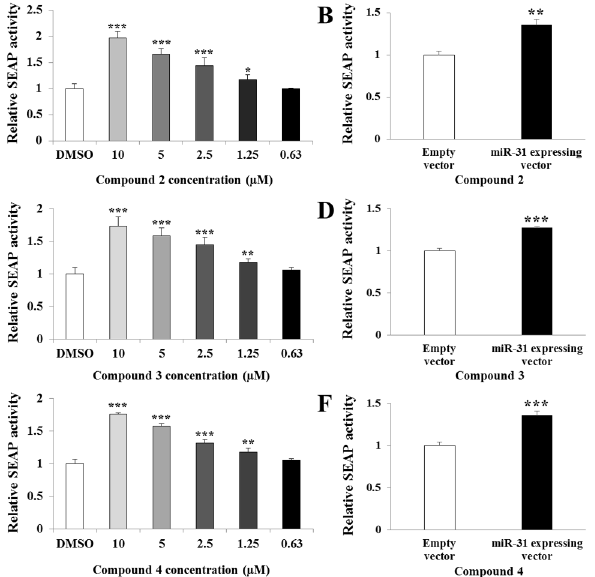
Fig 2. Screening of compounds with miR-31-modulating activity using the SEAP reporter assay. HEK- 293Tcells were co-transfected with the miR-31expressionconstruct (A, C, E) or empty miRNAexpression construct (B, D, F) and the SEAP reporterconstructcontainingmiR-31bindingsites in the 3 0 UTR of the SEAP reportergeneand subsequently treated with the compoundsfor 24 h. Culturesupernatants were then collected for detectionof SEAP activity. In eachexperiment,transfection efficiency was assessedby measuringGFP produced from the miR-31expressionvector. Cellstreated with compounds 2 (A), 3 (C), and 4 (E) showeda dose-dependentincreasein SEAP activity in the presenceof miR-31comparedto that of the DMSO-treated controls. However,compounds 2 (B), 3 (D), and 4 (F) did not increaseSEAP activity without miR-31expression. SEAP activity is presented as mean ± SD. * ,p < 0.05; ** ,p < 0.01; *** ,p < 0.001(Student’s t -test).